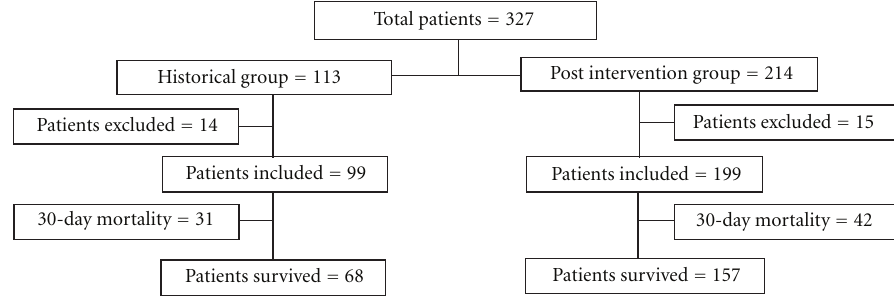
Figure 1: Distribution of patients evaluated by study groups.